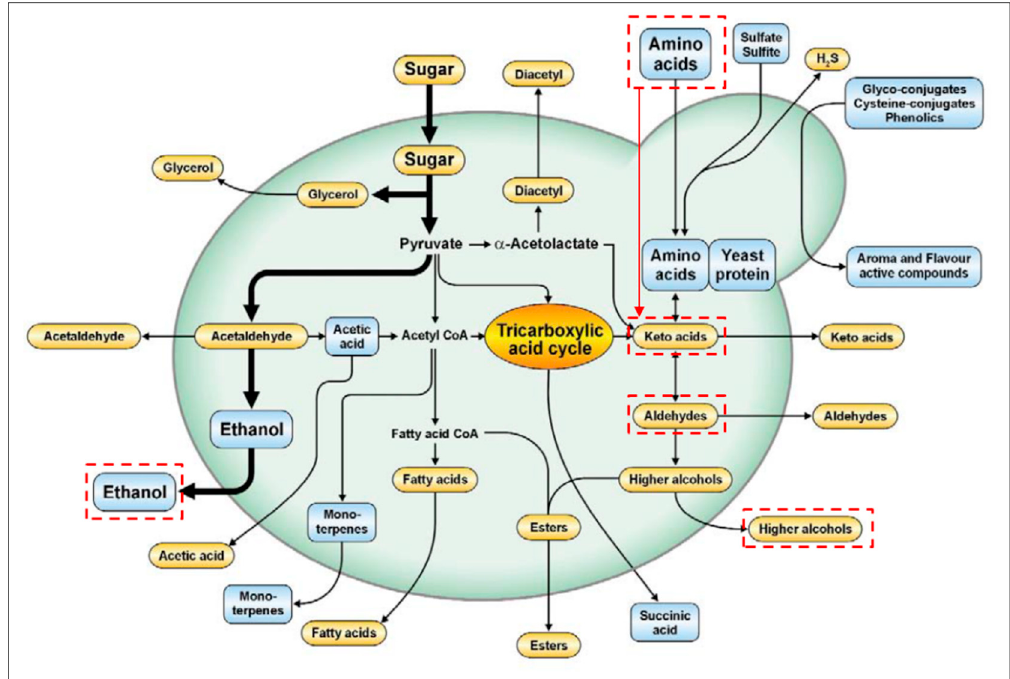
Figure 7. A schematic representation of the derivation and synthesis of flavor-active compounds from sugar, amino acids and sulfur metabolism by wine yeast, adapted from [85].